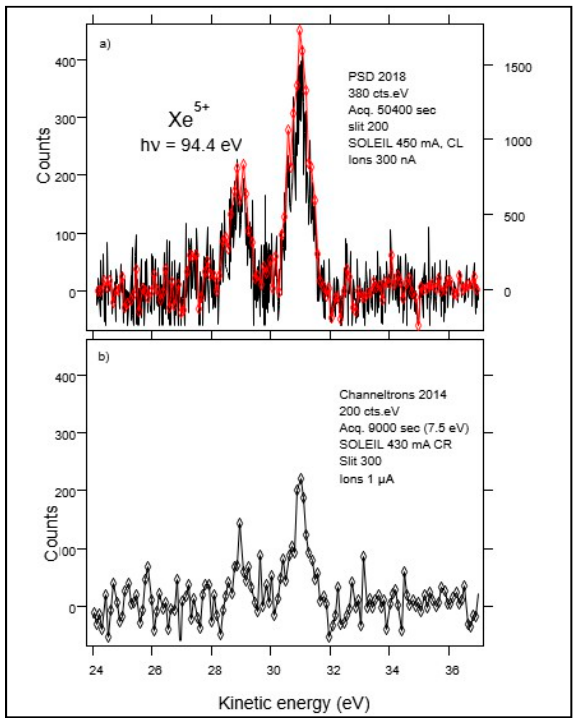
Figure 5. Comparison of electron spectra in Xe 5+ (4d → 4f) resonance with different detection systems: ( a ) Position sensitive detector with 5 MCPs versus ( b ) 8 channeltrons. The energy step is 20 meV in ( a ) and 100 meV in ( b ). To make the comparison easier, the red curve in ( a ) was summed on 5 points to compare the counts rate (right scale) with ( b ) with the same 100 meV steps.